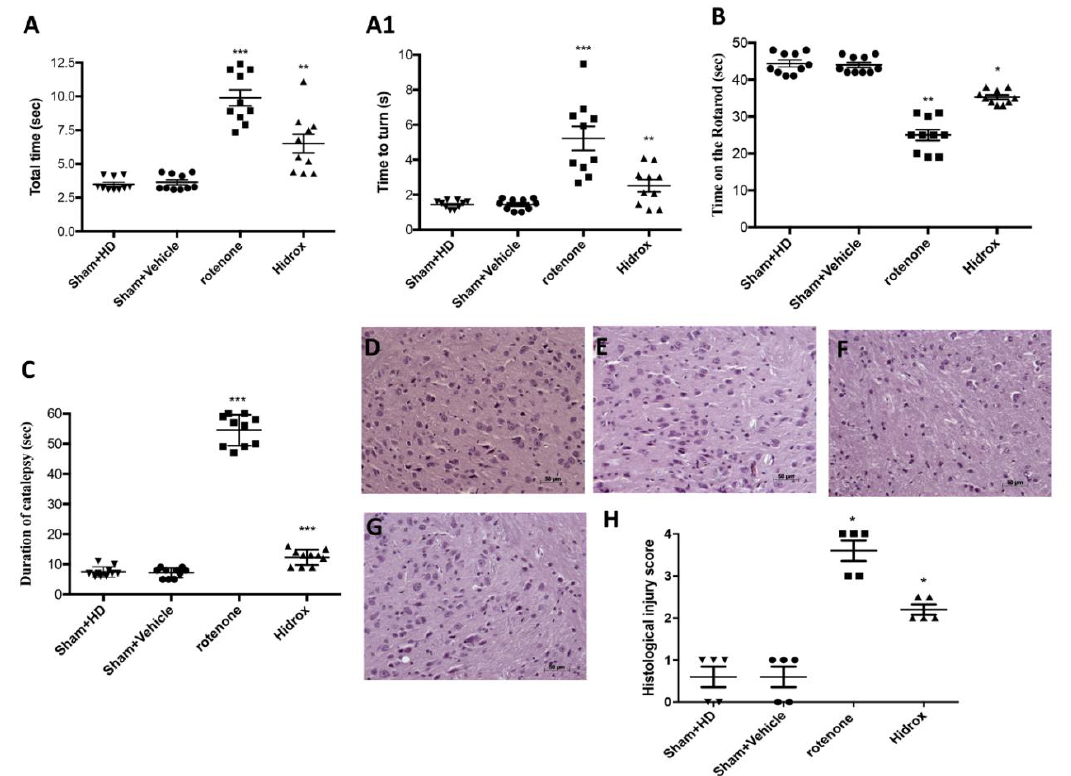
Figure 1. Effect of HD on behavioral impairments and on histological parameters induced by rotenone intoxication. ( A , A1 ) Motor function was assessed using a Pole test. At 28 days, mice exhibited a significant motor dysfunction as indicated by an increase in “Time to turn” and “Total time” spent to descend to the floor following injection of rotenone compared with the Sham group. HD administration notably reduced “Total time” and “Time to turn”. ( A ) *** p < 0.001 vs. Sham; ** p < 0.01 vs. rotenone; ( A1 ) *** p < 0.001 vs. Sham; ** p < 0.01 vs. rotenone. ( B ) At 28 days, using a Rotarod apparatus, mice exhibited a significant motor dysfunction as indicated by a decrease in time spent on the Rotarod. HD treatment blunted the motor dysfunction in mice. ( B ) ** p < 0.01 vs. Sham; * p < 0.05 vs. rotenone. ( C ) Catalepsy was evaluated according to the standard bar hanging procedure; this motor test showed that the HD treatment reduced behavioral impairment induced by rotenone. ( C ) *** p < 0.001 vs. Sham; *** p < 0.001 vs. rotenone. Values are the mean ± SEM of 10 mice for each group. Sham+HD and Sham+vehicle groups showed no evidence of degenerating cellsintheSN( D , E ),whereasdegenerationof neuromelanin-pigmented cells was evident in the SN of the rotenone-treated animals ( F ). HD treatment restored the architecture compared to the control mice ( G ). The data are representative of at least three independent experiments and are expressed as the mean ± SEM of 5 mice for each group. ( H ) * p < 0.05 vs. Sham; * p < 0.05 vs. rotenone. Scale bar: 50 µ